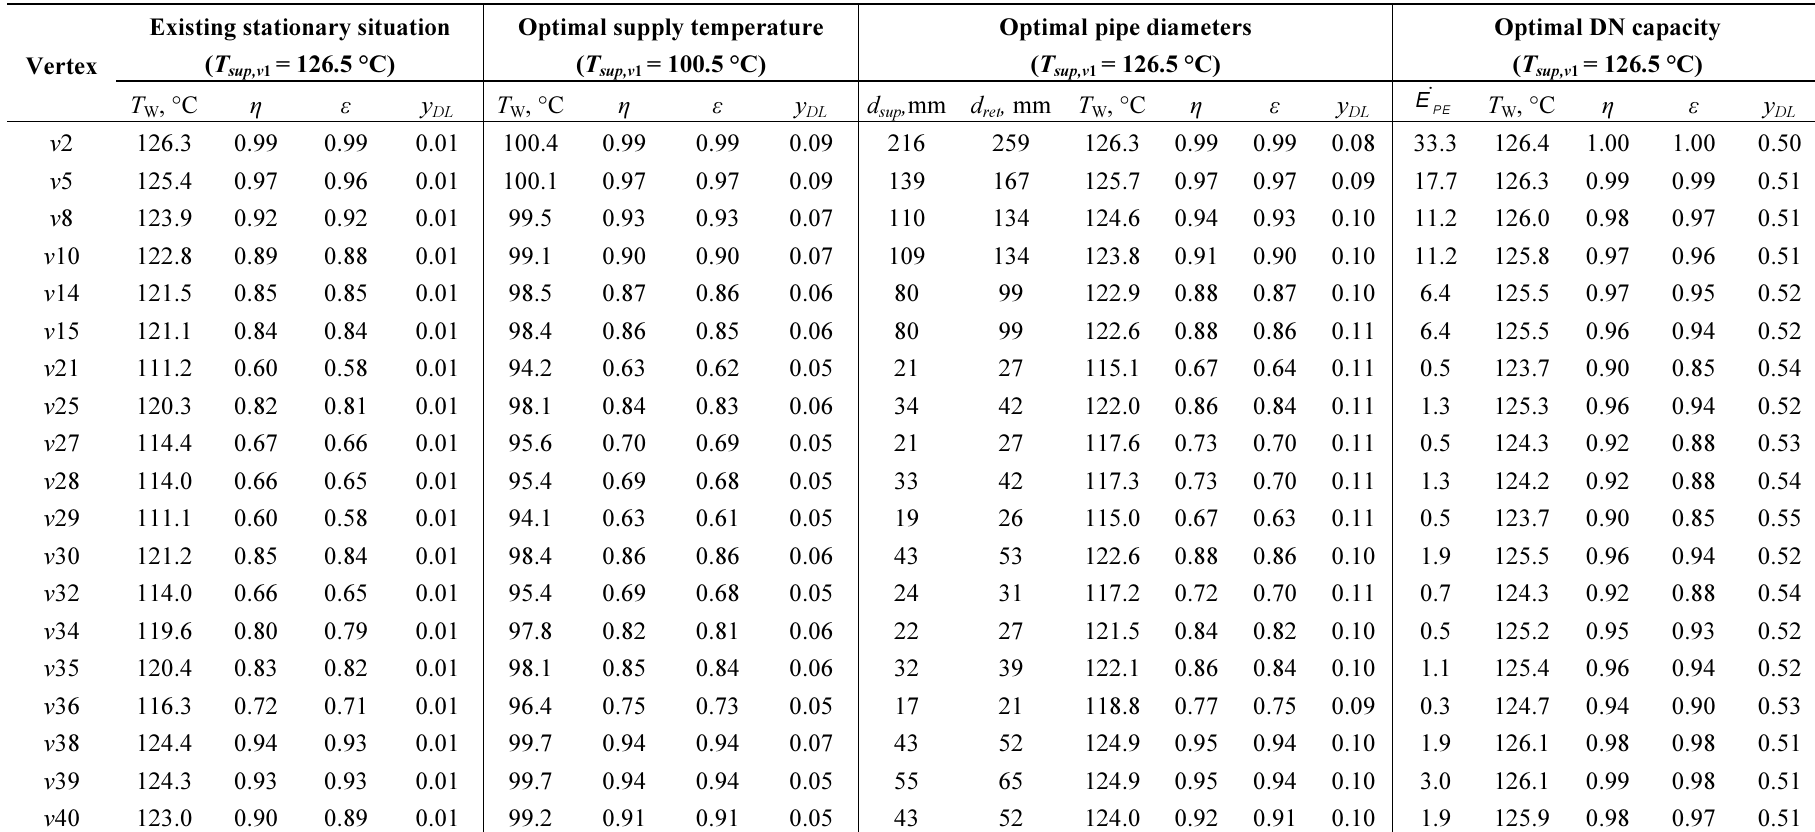
Table 3. Results from the energetic and exergetic